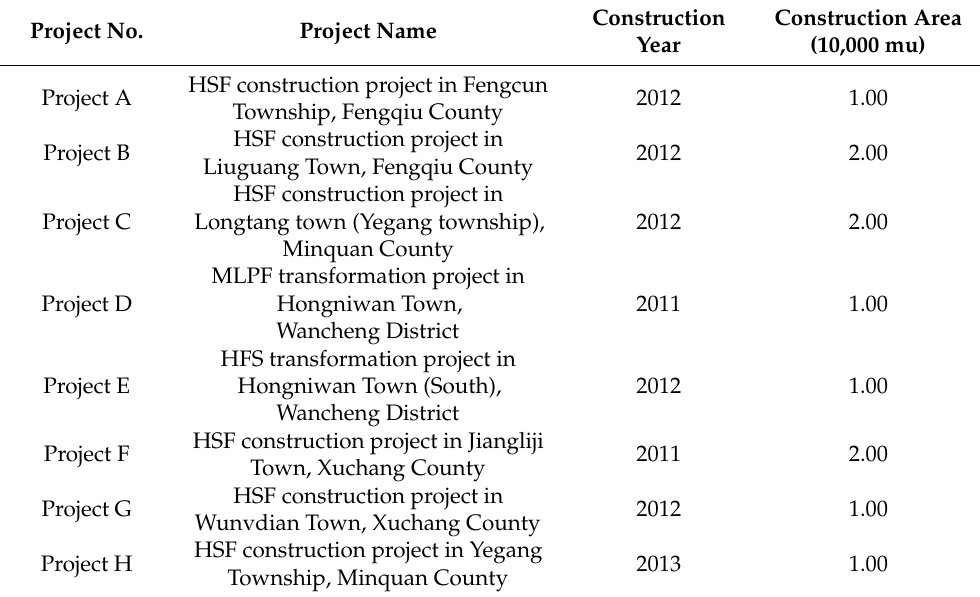
Table 2. The project regions of sampling survey in Henan